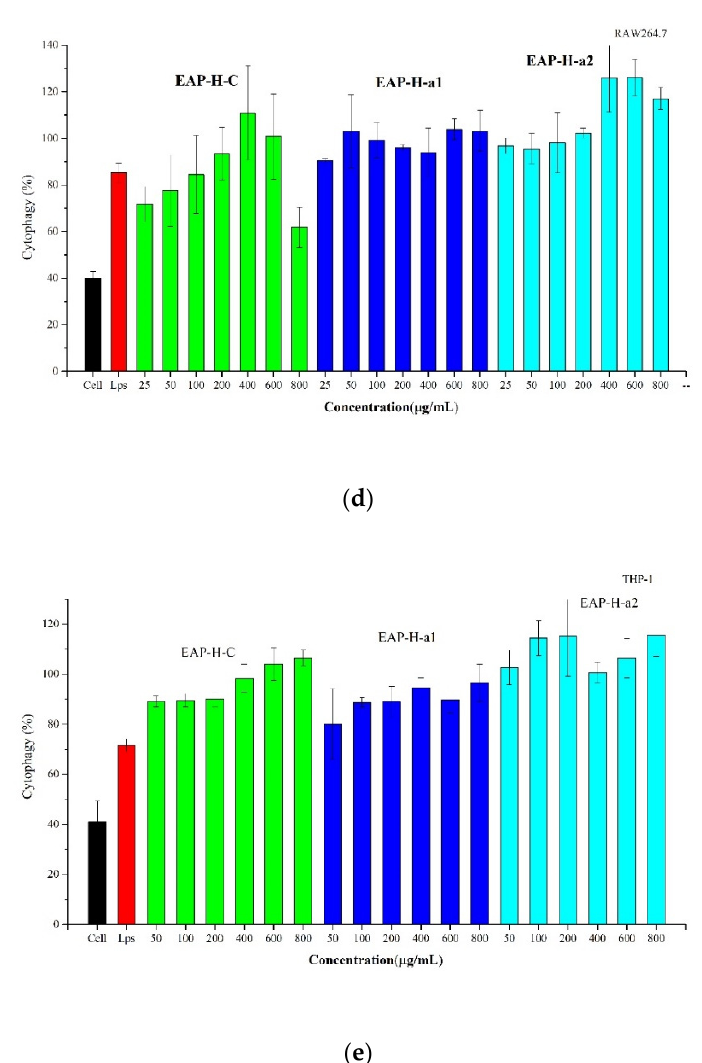
Figure 10. Effects of different concentrations of polysaccharides on the cell viabilities on RAW 264.7 ( a ) and THP-1 ( b ); NO production on RAW 264.7 ( c ); phagocytic capacity on RAW 264.7 ( d ) and THP-1 ( e ).